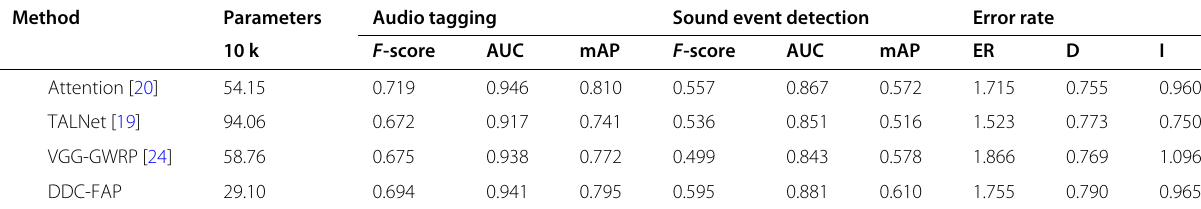
Table 7 The results of DCASE 2020 Task 4 dataset